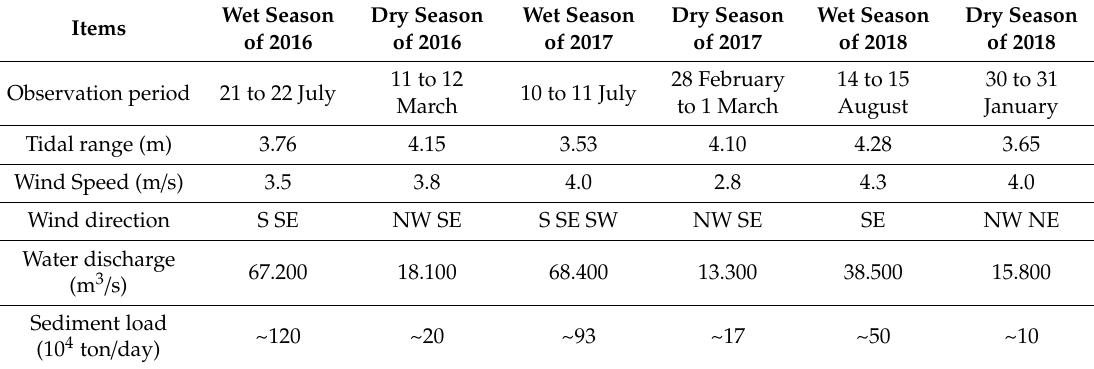
Table 1. Time period and dynamic environment during six observations.